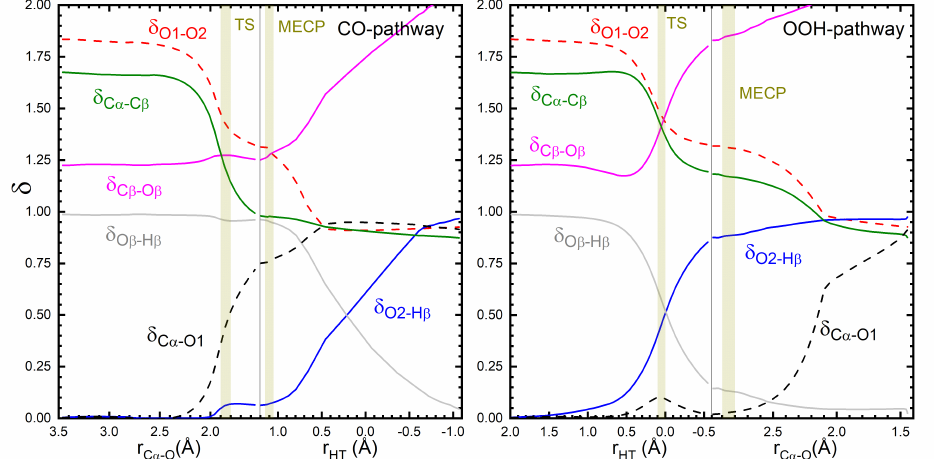
Figure 4. Evolution of delocalization indices along the addition of O 2 to 2-methyl-3,4-dihydro-1- naphthol along the reaction path calculated at the M062X-D3/maug-cc-pVDZ level of theory. Results for the CO-pathway and the OOH-pathway are shown in the left and right panels, respectively. The locations of the two TSs and MECPs are shown as vertical shaded